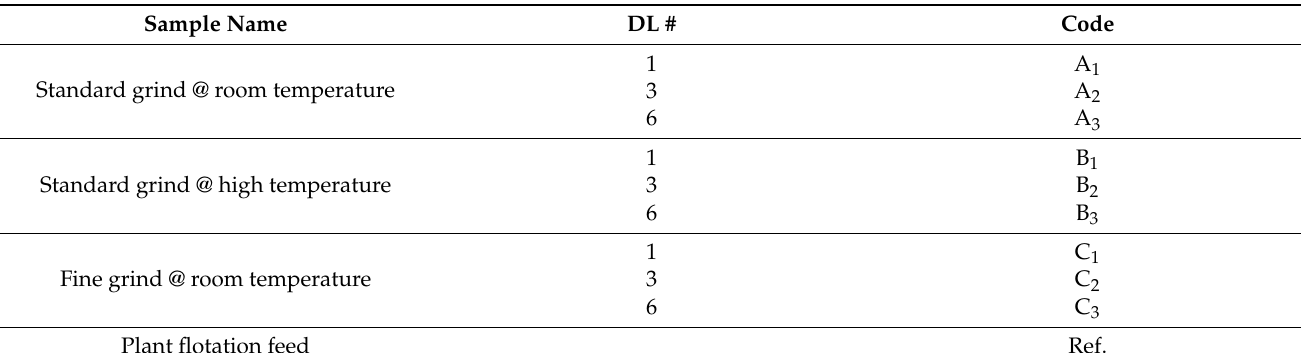
Table 3. Sample codes for all